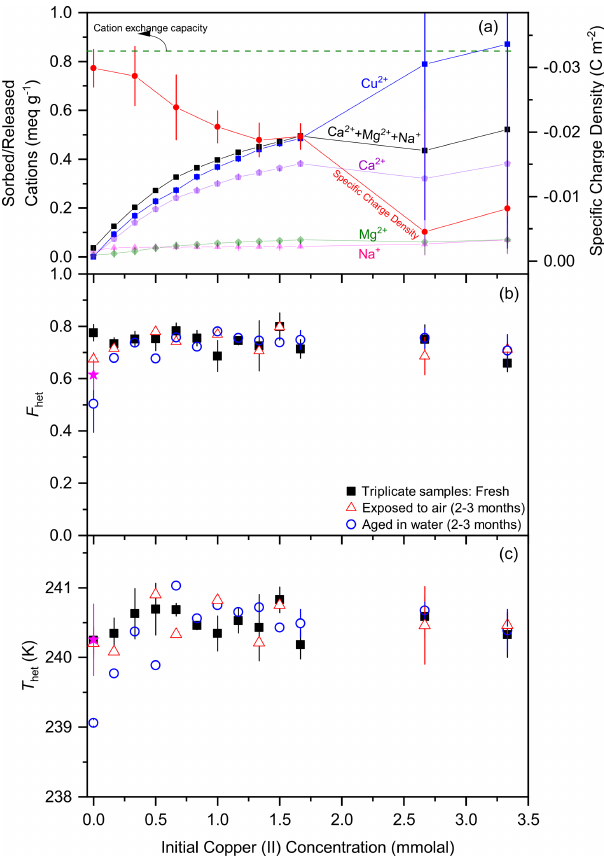
Figure 4. Ion exchange experiments as a function of Cu 2 + con- centration in a 0.5wt% STx-1b suspension showing the effect of the stepwise exchange of the charge-balancing cations (Ca 2 + and minor amount of Mg 2 + and Na + ) with Cu 2 + on the IN activ- ity of the montmorillonite. Panel (a) shows sorbed Cu 2 + together with released Ca 2 + , Mg 2 + , and Na + as separate curves and sum to Ca 2 + + Mg 2 + + Na + in terms of meqg − 1 (left scale) together with the specific charge density on the montmorillonite particle surface (right scale). The horizontal dashed green line marks the CEC as reported by CMS. DSC thermograms of the freshly ion-exchanged and lyophilized samples as 1wt% suspensions in pure water have been measured in triplicate (black filled squares with error bars rep- resenting ± 1 SD) a few days after preparation and have been evalu- ated in terms of F het in panel (b) and T het in panel (c) . A few sam- ples have been re-measured after 2–3 months either after storage in air (open red triangles) or aged in water (open blue circles). The black square at 0mmolalY 3 + marks the sample that was treated the same way as the ion-exchanged samples (including lyophilization). As a reference, filled magenta stars indicate F het and T het of the original STx-1b in